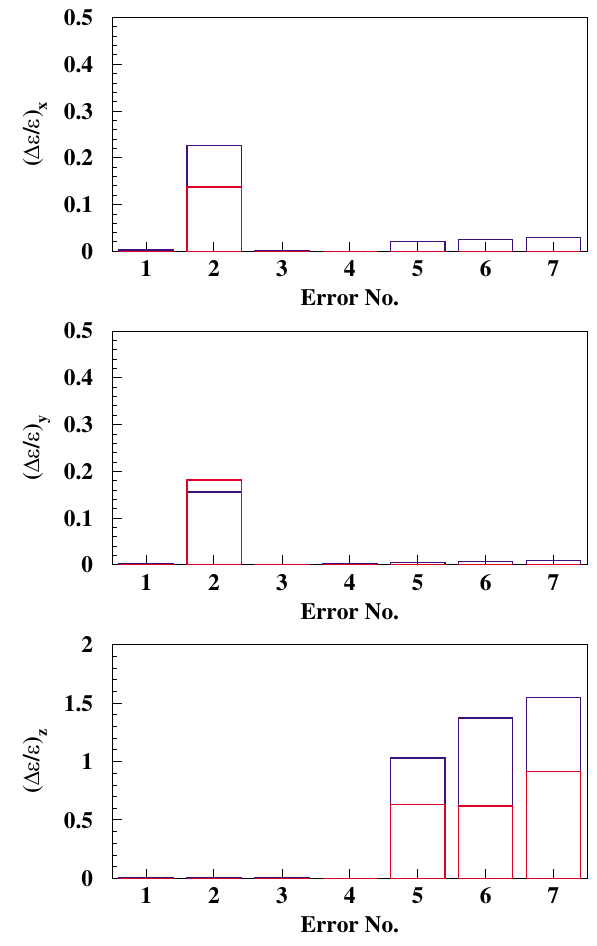
FIG. 11. (Color) Comparison of the sensitivity of the baseline and triple-spoke designs to the different source of errors of Table I. The plots show the increase in transverse and longitu- dinal beam emittances relative to the case without errors. The blue curves are for the baseline design and the red ones are for the triple-spoke